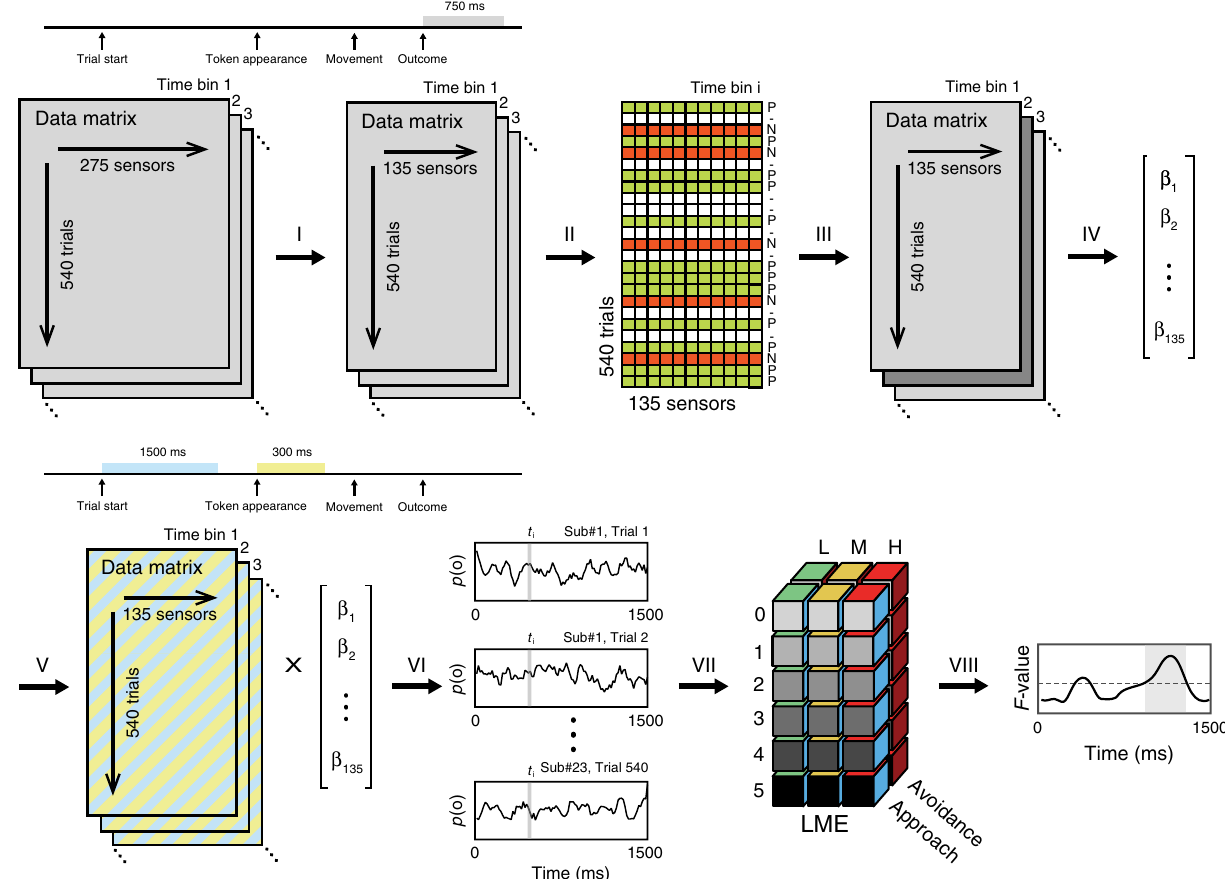
Fig. 5 Multivariate data analysis. Classi fi ers were trained on the MEG fi eld patterns acquired while participants were experiencing the outcomes (grey segment). For each participant, this was a data structure containing the magnetic fi eld at each of the 275 sensors acquired in each of the 540 trials. (i) Channel selection. The number of channels was reduced to 135 by selecting the participant-speci fi c subset containing the least eyeblink artefacts 41 . (ii) We then computed the cross-validated accuracy of the classi fi cation at each time bin. As training set, we retained approach trials in which either the positive (P, green) or the negative (N, red) outcome was presented, and discarded neutral and avoidance trials (hyphen, white). At this stage the regularisation λ coef fi cient was set to 0.025. (iii) The time bin of peak accuracy was then selected to build the training set of the classi fi ers, which (iv) were de fi ned as the 135 weights associated with each channel resulting from a lasso-regularised logistic regression. The λ coef fi cient used at this stage was optimised with a second cross-validation procedure. (v) Analysis of the deliberation phase: the classi fi ers were then used to estimate the relative probability that either outcome was being represented during deliberation aligned either to trial start (cyan segment) or token appearance (yellow segment). (vi) The classi fi cation resulted in outcome representation probability ( p (o)) time series of which we considered one time bin at the time to (vii) compute a LME and extract fi xed-effects statistics (loss probability: low (L), medium (M), high (H); loss magnitude: 0 – 5; choice: approach, avoidance). (viii) For statistical inference, we applied a non-parametric cluster-level correction over the F -values of the main effects resulting from the